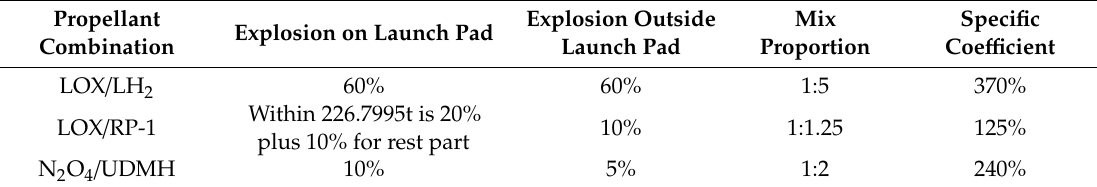
Table 4. Equivalent yields at di ff erent stages of a certain rocket.